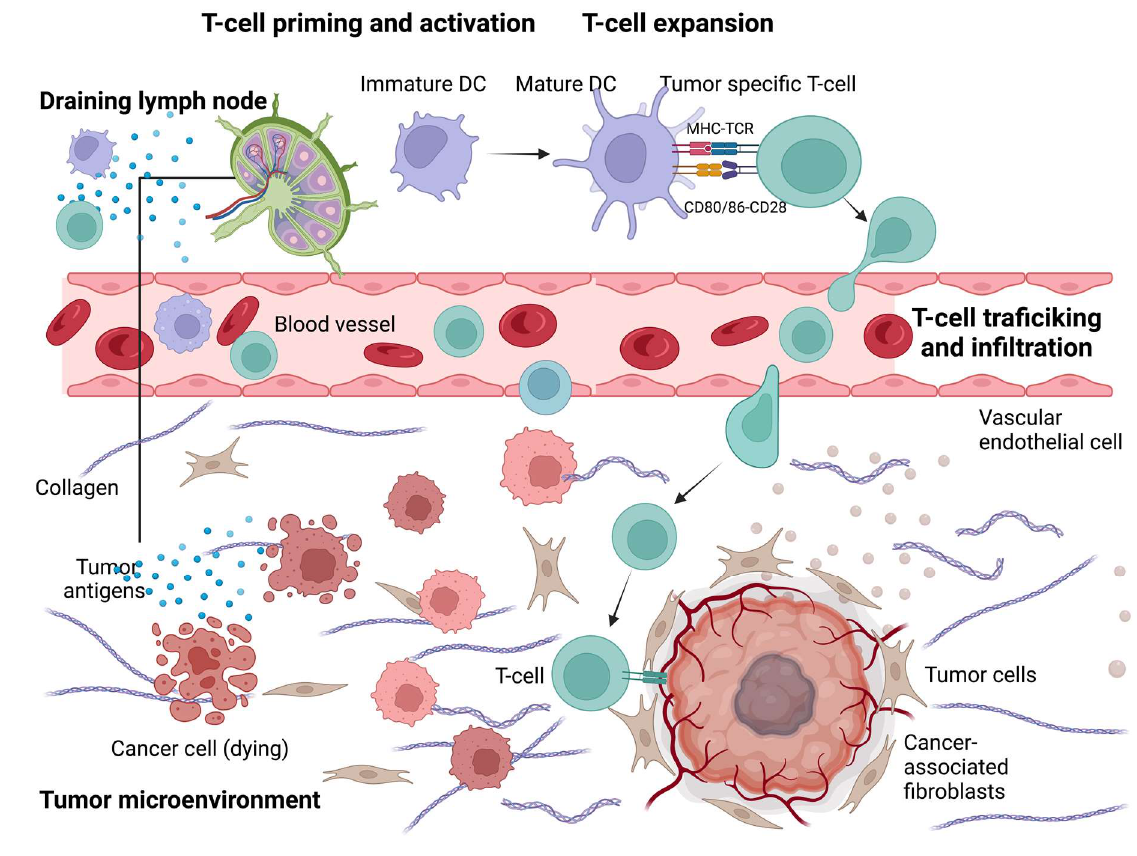
Figure 6. Approaches to turn a “cold tumor” into a “hot tumor”. Some representative therapeutic strategies to increase T cell infiltration and improve the efficacy of ICI. T cell priming and activation: Oncolytic viruses, local thermal ablation therapy (e.g., radiofrequency ablation), chemotherapy, and radiotherapy are all capable of inducing immunogenic cell death to promote T cell priming and activation. Local administration of immune adjuvants, such as TLR agonists, promotes the activation of DCs. Epigenetic modification inhibitors can promote T cell priming by increasing the expression of tumor antigens and by restoring antigen processing and presentation mechanisms. T cell expansion: Cancer vaccines and adoptive cellular therapies, such as CAR-T cells, can promote the expansion of tumor-specific T cells. T cell trafficking and infiltration: Intrinsic oncogenic pathway inhibitors, antiangiogenic therapies, TGFβ inhibitors, CXCR4 inhibitors, and epigenetic modification inhibitors can promote T cell trafficking and enable T cells to infiltrate the tumor more effectively. Adapted from ref. [124]. Created with Briorender.com (URL (accessed on 18-11-2022). Definitions of abbreviations are found in the abbreviations list at the end of the text.